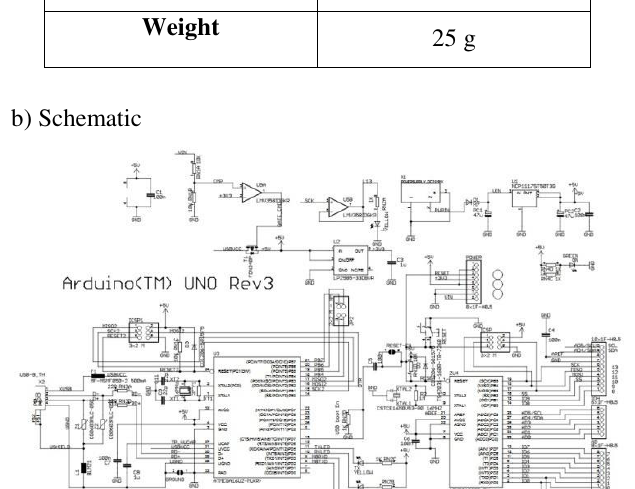
Figure 2. Schematic diagram of Arduino Uno board